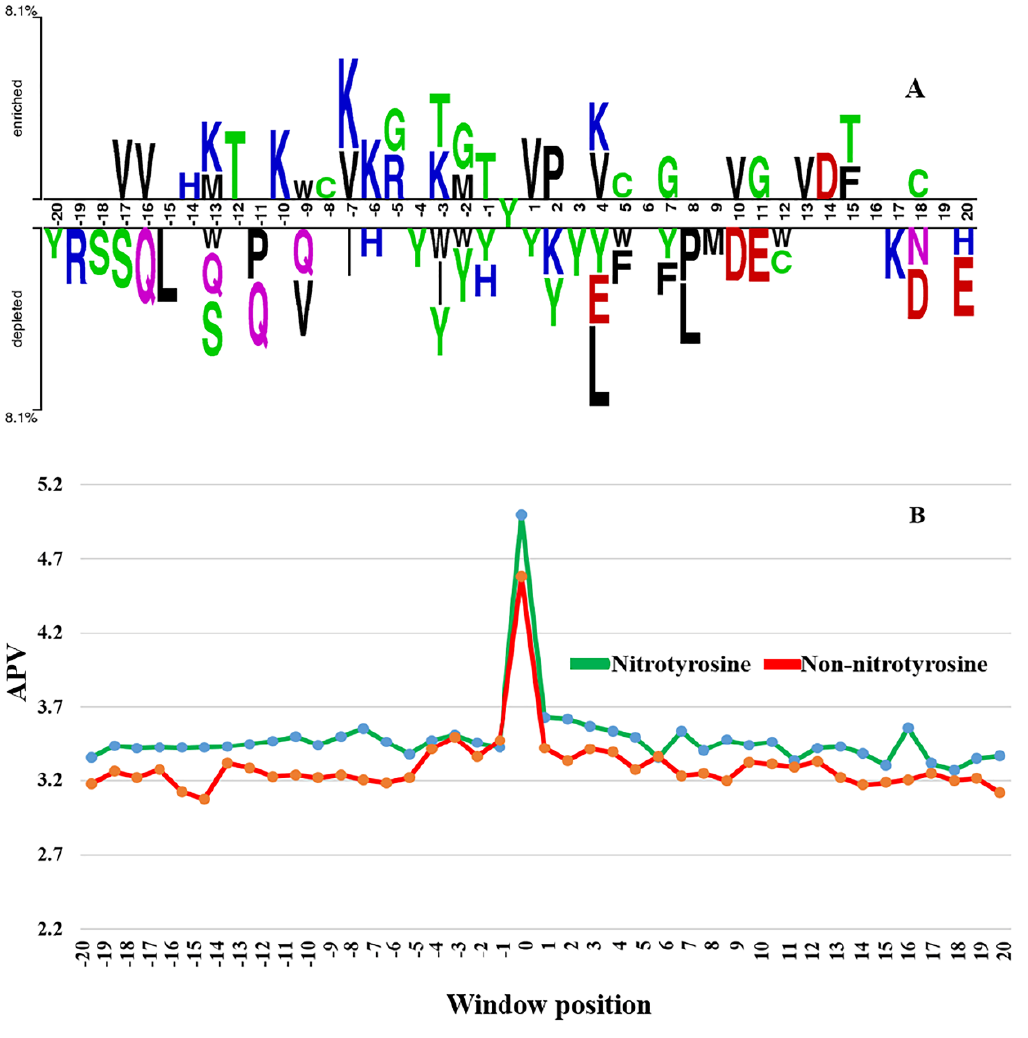
Figure 2. Comparison of sequence information between nitrotyrosine and non-nitrotyrosine sites. ( A ) A two-sample logo for training dataset of NTyroSite in compositional bias sequences of surrounding nitrotyrosined proteins; ( B ) we calculated the average PSSM value (APV) of each position (i.e., the average positions of each row of the PSSM matrix) in the flanking sequences of each nitrotyrosine (green color)/non-nitrotyrosine (red color) site, to investigate the protein evolutionary conservation of nitrotyrosine or non-nitrotyrosine sites. Because the optimal window size in this study was 41, the APVs of the positions [+1, +20] were averaged to obtain the APV of the downstream sites, while the APVs of the positions [ − 20, − 1] were averaged to obtain the APV of the upstream sites. p -values were also calculated using the Kruskal–Wallis test and corrected using Bonferroni (See Table S1).